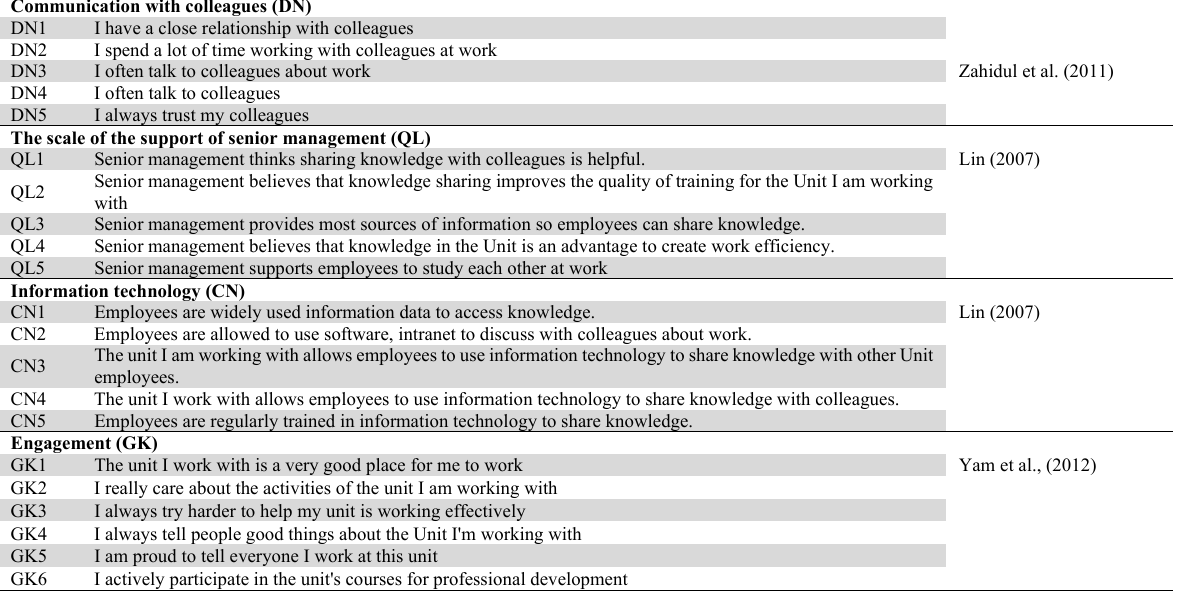
Scale Mean if Item Deleted